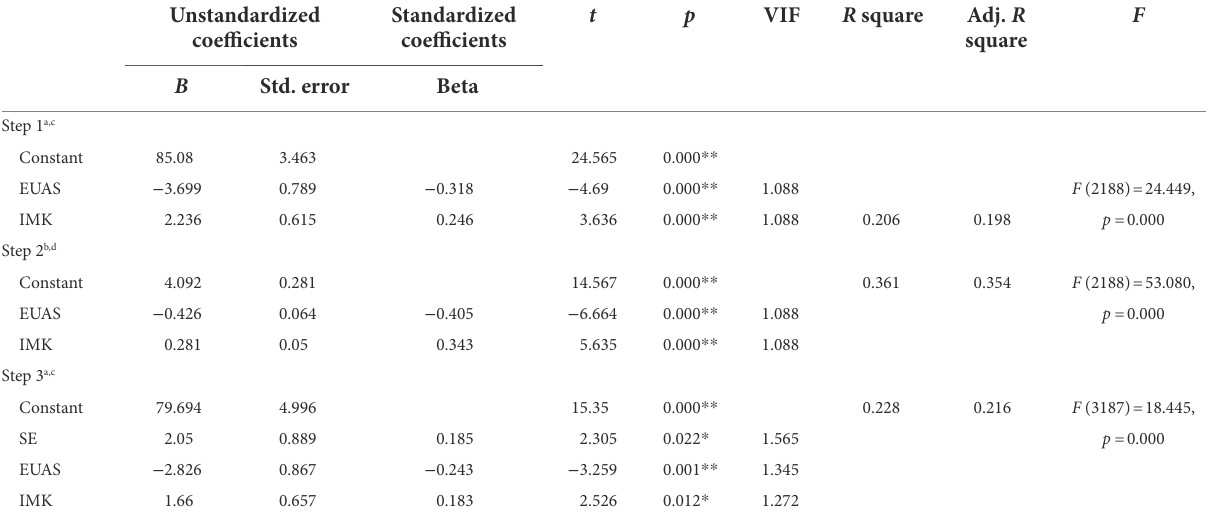
TABLE 5 Multiple regression analysis for examining the mediating